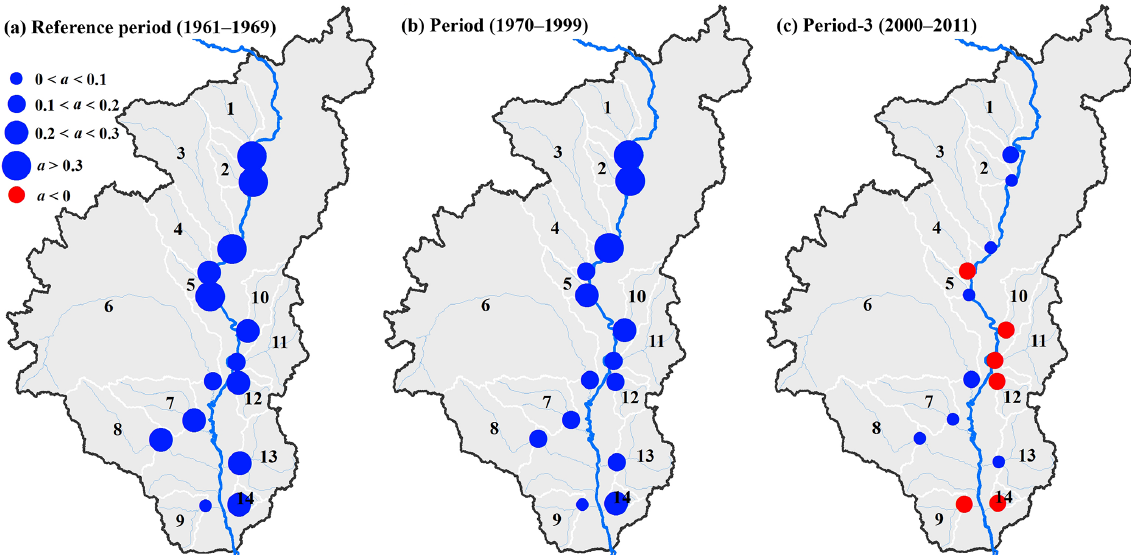
√ Figure 9. Spatial distribution of slope a in the regression equation SSY = aP + b during (a) the reference period (1961–1969), (b) period-2 (1970–1999), and (c) period-3 (2000–2011). SSY is the specific sediment yield, and P is precipitation. Table 4. The regression models for sediment yield change ( (cid:49) SSY) in different stages. Period Regression model R 2 p Reference period vs. period-2 (cid:49) SSY = − 0 . 135–0.850 × (cid:49) Dam 0.886 Reference period vs. period-3 Period-2 vs.